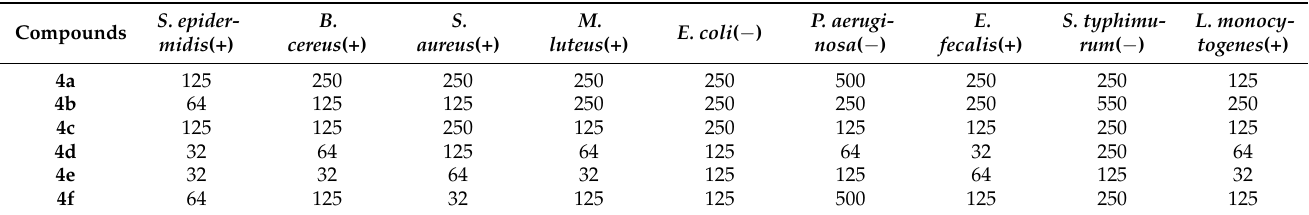
Table 5. Antibacterial activities of 4a – i and 6a – b : minimum inhibitory concentration (MIC).